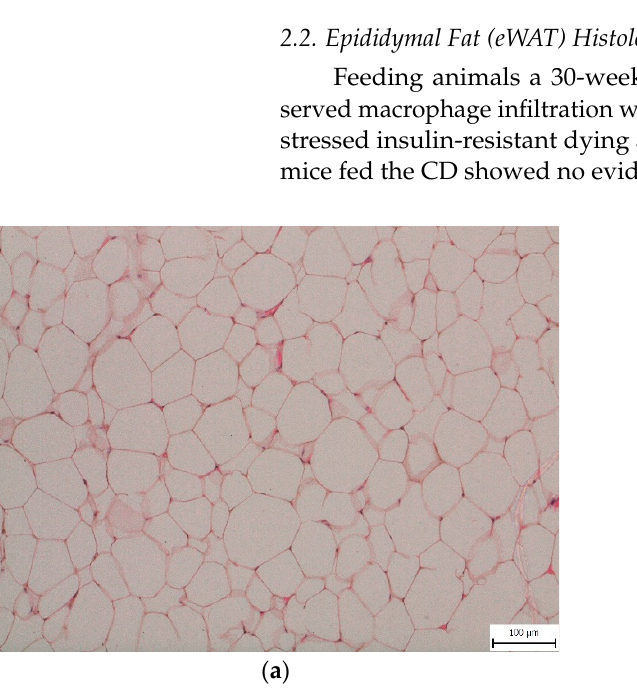
Figure 1. Representative histopathological samples of epididymal adipose tissue taken from mice fed ( a ) a control diet (CD30) or ( b ) a Western ‐ style diet (WD30) for 30 weeks—hematoxylin and eosin staining. Arrows indicate macrophage crown ‐ like structures in the WD30 group.